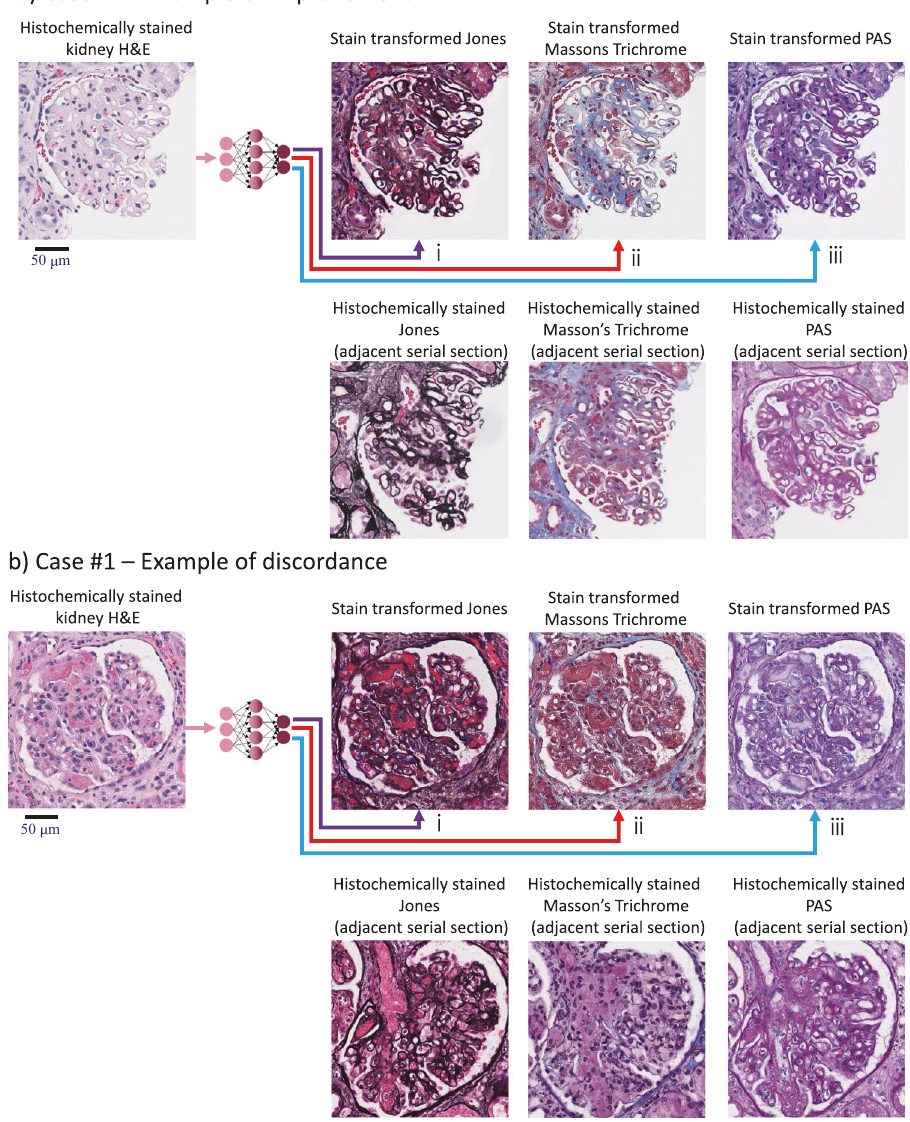
Fig. 6 Examples of improved and discordant diagnosis achieved by the stain-transformed special stains. a Example of improved diagnosis fostered by the stain-transformed special stains. For case #2 (in Fig. 4 and the Supplementary Data 1), the basement membrane changes that are characteristic of membranous nephropathy (subepithelial spikes and basement membrane holes) are only appreciated after reviewing the stain-transformed JMS. The bottom images exemplify histochemically stained images of adjacent serial sections of the patient sample; that is why they correspond to different sections within the tissue block. b Example of the discordance demonstrated between the H&E and computationally generated special stains for case #1 (in Fig. 4 and the Supplementary Data 1). In this fi eld of view, the fi brin thrombi are gray-yellow in color on the stain-transformed PAS stain rather than pink-red. (i) Generation of JMS. (ii) Generation of MT. (iii) Generation of PAS. A total of 58 cases were viewed by three pathologists to perform the statistical